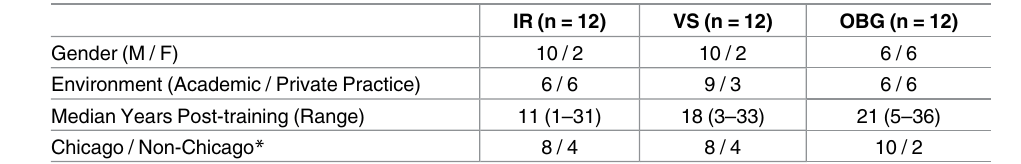
Table 1. Physician interview demographics.